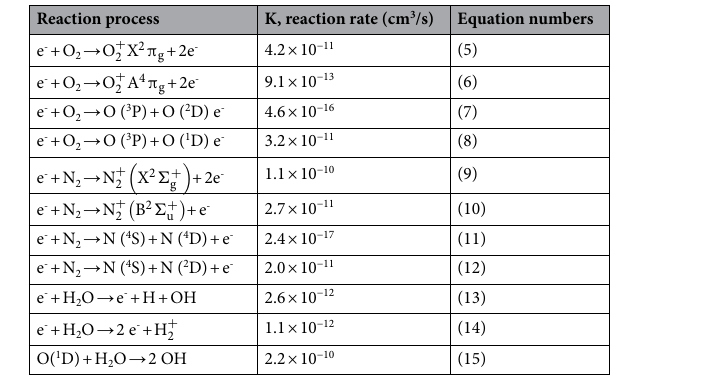
Table 2. Important ionization reactions involving the breakdown of air molecules to form active species in the enhanced ionization